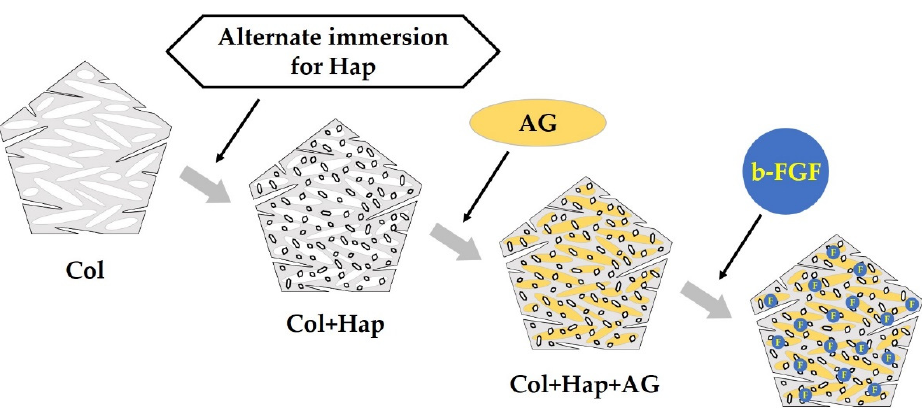
Figure 17. Preparation order and method for constructing granules consisting of collagen (Col), hydroxyapatite (Hap), acidic gelatin (AG), and b-FGF.